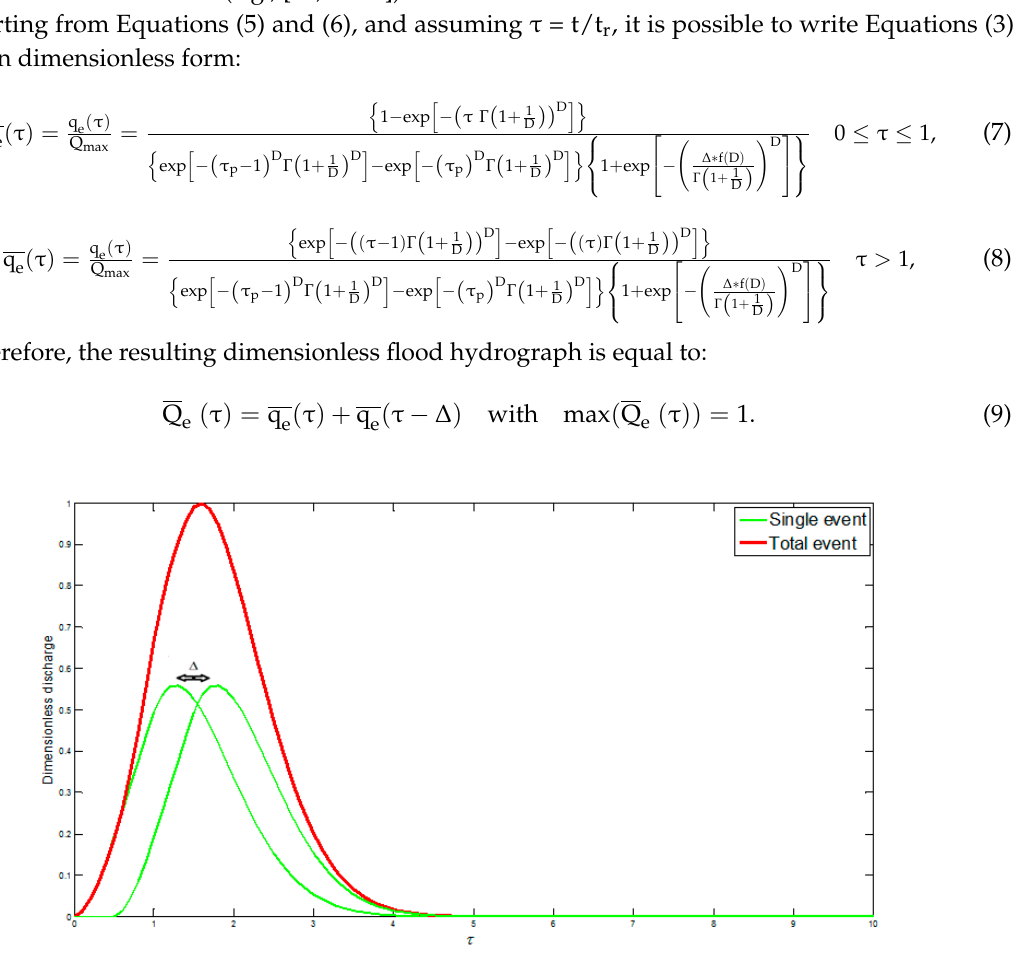
Figure 1. Composition of the dimensionless flood hydrograph, starting from the two single flood hydrographs with a fixed time shift.